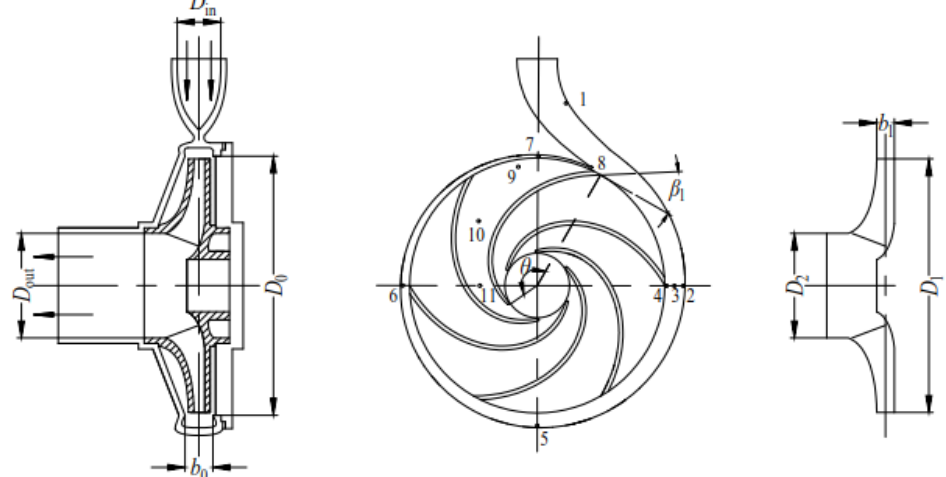
Figure 2. Structure and pressure monitoring points of PAT.